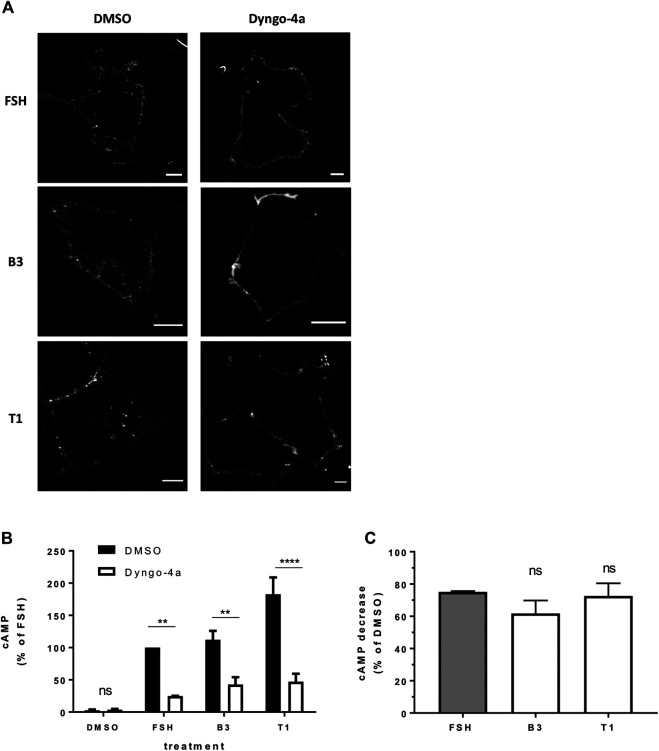
FSHR requires receptor internalization to induce cAMP signaling in response to either FSH or LMW agonists. (A) Confocal images of FLAG-FSHR stably expressing HEK 293 cells pre-treated with either DMSO or Dyngo-4a (30 μM, 30 min) and stimulated with FSH (10 nM), B3 (10 μM) or T1 (10 μM). Scale bar = 5 μm. (B) Intracellular levels of cAMP measured in cells via HTRF expressing FLAG-FSHR pre-treated with either DMSO or Dyngo-4a (30 μM, 30 min) and stimulation either DMSO, FSH (10 nM, 5 min), B3 or T1 (10 μM, 5 min). Data are expressed as cAMP levels normalized to FSH treatment (DMSO). Two-way ANOVA: **p < 0.01, ****p < 0.0001. (C) Percentage decrease in cAMP levels following Dyngo-4a pre-treatment calculated from (B). n = 3 independent experiments.